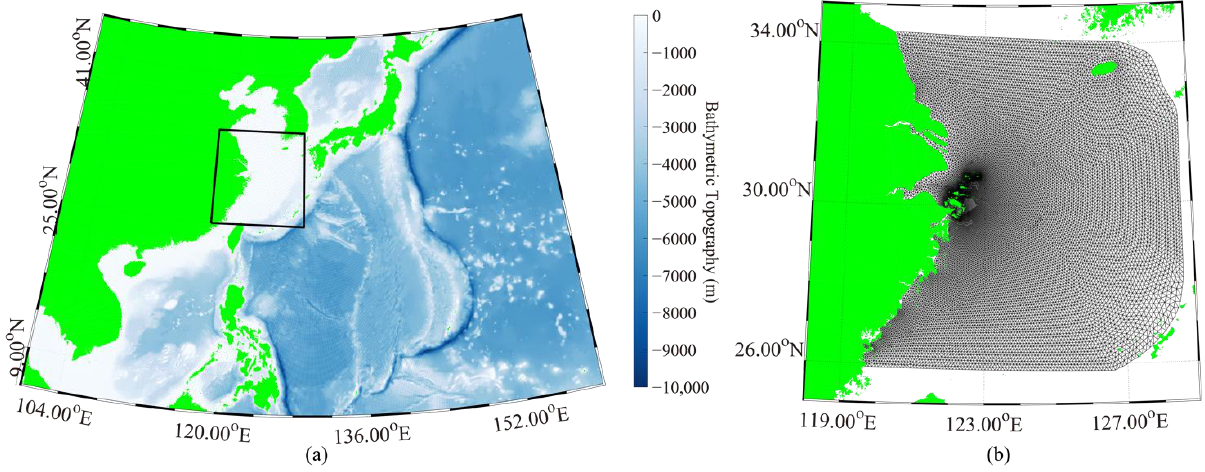
Figure 1. ( a ) The large-scale map of the study area with the depth level; the black rectangle represents the location of ( b ). ( b ) The geographic map of the spatial coverage of the Sanchi accident, in which the unstructured grids are uniquely used for sea-surface current and wave simulations using the Finite-Volume Community Ocean Model (FVCOM) and the Simulating WAves Nearshore (SWAN) model, respectively.